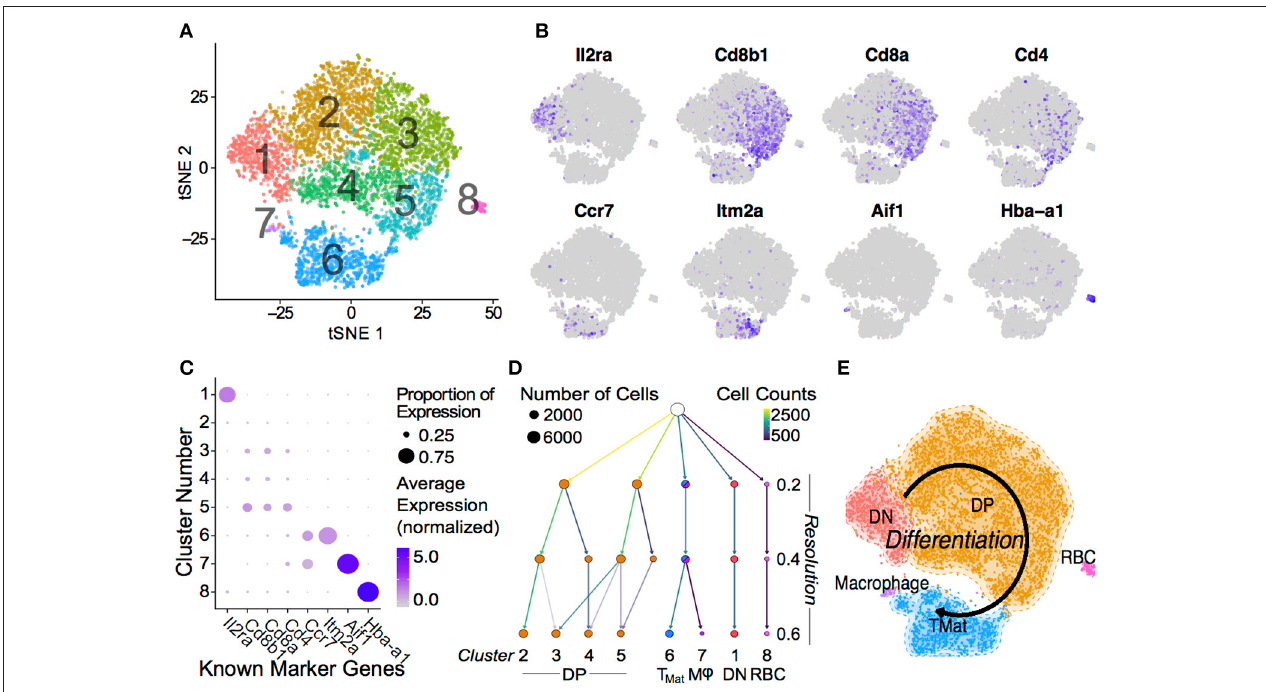
FIGURE 2 | Single Thymic Cell Transcriptomics reveal T-Cell Differentiation Pathway. (A) Drop-Seq of 7,264 single-cells from WT and P 0 thymi were mapped using non-linear dimensional reduction [t-Distributed Stochastic Neighbor Embedding (tSNE)] using WT signatures derived from linear dimensionality reduction (Principal Component Analysis, PCA), with signal from known cell cycle genes regressed. Cells separated into eight clusters, denoted by color, and number. Known marker genes were used to identify each cluster. (B) Marker transcript levels across cells. Purple indicates detected transcripts. (C) Marker transcript levels within each cluster. Average Expression Normalized refers to the amount of transcripts discovered while Percentage Expression denotes the proportion of cells within a given cluster containing the transcript. (D) Consistency of sub clustering was assessed at three levels of resolution. (E) Overall, these markers yielded a differentiation map from DN in Cluster 1 through to mature T cells in Cluster 6. RBC: Red blood